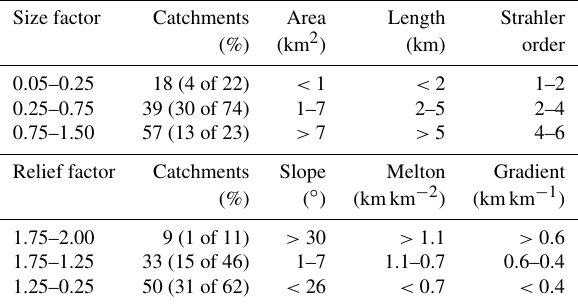
Table 2. Table that summarizes the percentages of catchments prone to generate debris flows and presents thresholds of topographic at- tributes that contribute within each